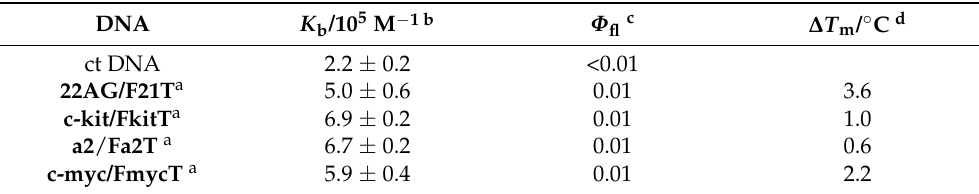
Figure 2. Photometric titration of 2 ( c = 20 µ M) with ct DNA ( a ) in a BPE buffer ( c Na+ = 16 mM, pH 7.0, with 5% v / v DMSO) and with a2 ( b ) in a K-phosphate buffer ( c K+ = 110 mM, pH 7.0, with 5% v / v DMSO). The arrows indicate the changes in absorption upon the addition of DNA. Inset: Plot of the absorption at 345 nm versus DNA concentration. Table 2. Binding constants, K b , and shifts of DNA melting temperature, ∆ T m , of 2 with ct DNA and G4-DNA, and fluorescence quantum yields, Φ fl, of the DNA-bound